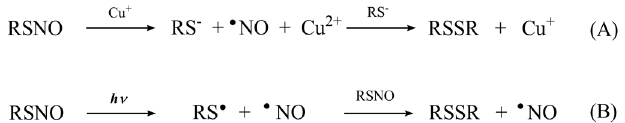
FIGURE 8 - General mechanism of nitrosothiol decomposition and NO release, (A) copper-mediated and (B) photo-initiated (adapted from Stasko, Fischer, Schoenfisch,